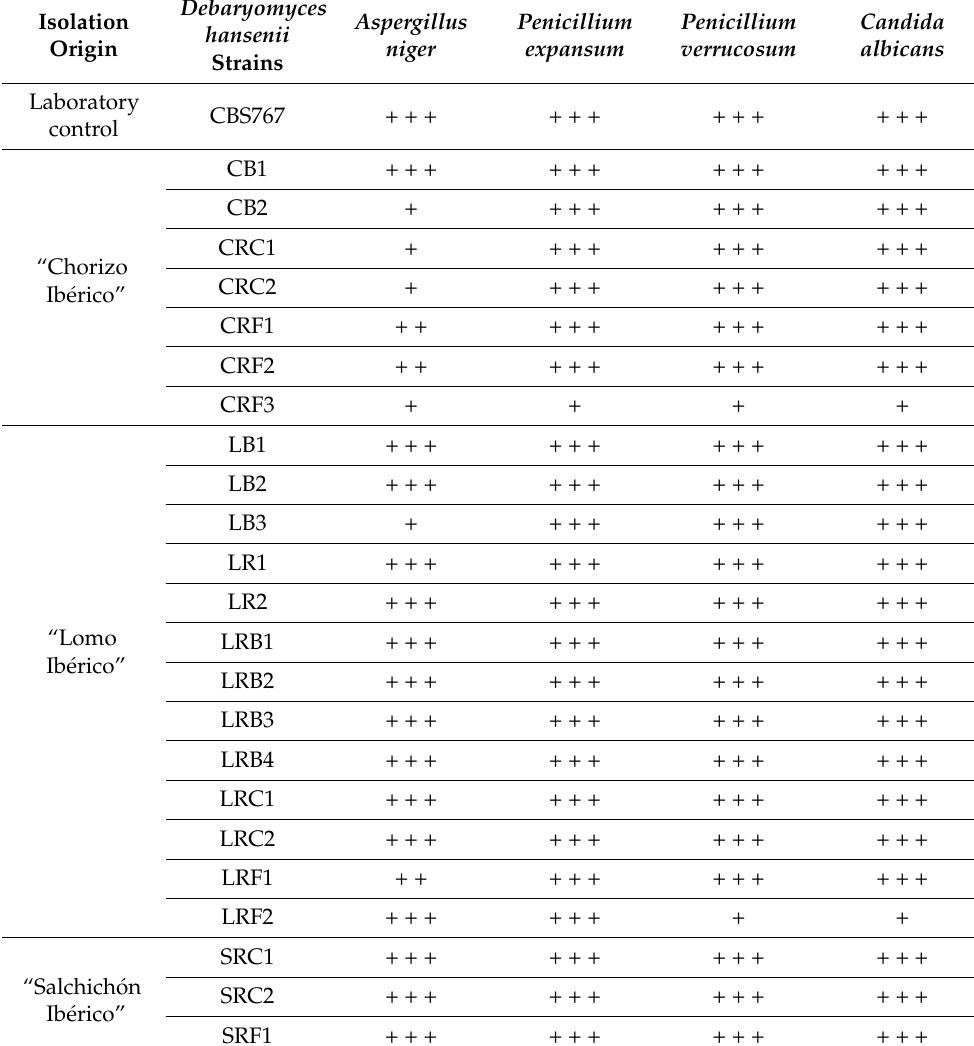
Table 1. Representation of the results obtained in the study of pathogenic fungi colonization preven- tion assay with biofilms from D. hansenii strains (primary